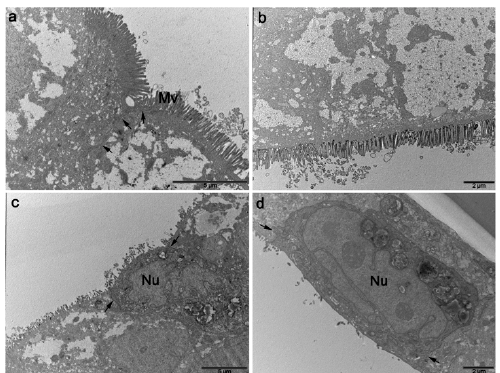
Figure 5. TEM micrographs of: ( a ) Caco-2 monoculture, ( b ) Caco-2/HT-29 MTX co-culture, ( c ) Caco-2/Raji B co-culture, and ( d ) Caco-2/HT-29 MTX/Raji tri-culture at the 21st day of culture. Differentiated epithelial cells show the typical brush border and TJ of the intestinal barrier ( a , b ) while, in the tri-culture with Raji B cells, cells are characterized by the loss of microvilli (mV) displayed always a more electrodense cytoplasm and the absence of the typical electron transparent accumulation of amorphous material of Caco-2 cells. Bars a and c 5 µ m; b and d 2 µ